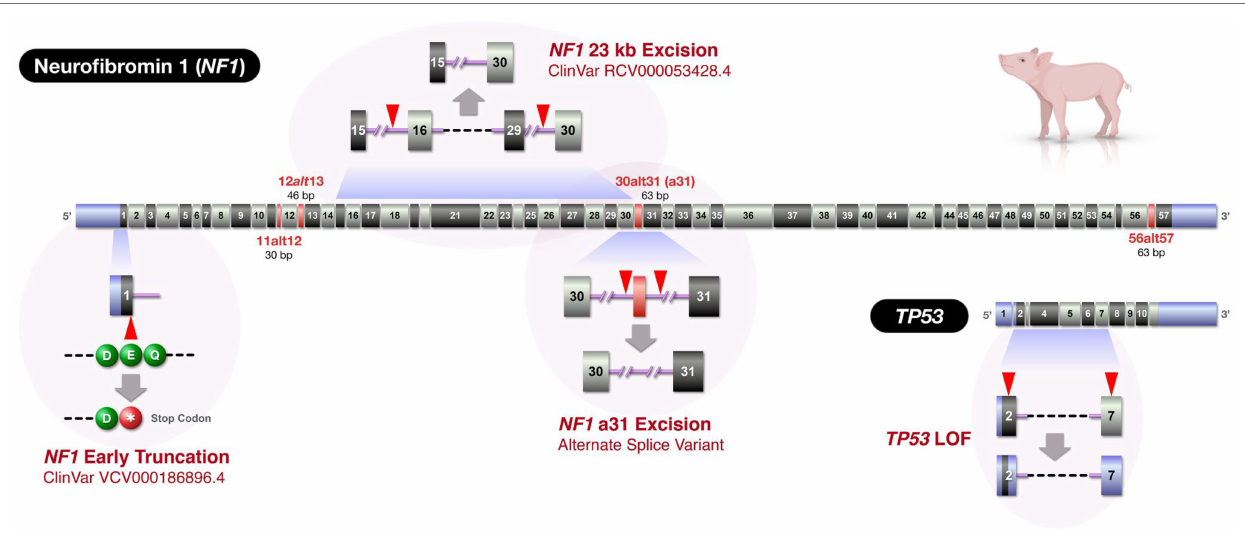
FIGURE 2 | Swine NF1 and TP53 gene maps and locations of genetic alterations in the novel swine models. The figure depicts three NF1 edits and a TP53 edit. Due to the large size of the NF1 gene, the figure only displays exonic regions (to relative scale) of the two genes ( NF1 : ENSSSCT00000019317.4 and TP53 : ENSSSCT00000019534.4). Exons displayed as red indicate alternatively spliced exons homologous to those in humans. The exon numbering was based on Ensembl Sscrofa11.1, but alternatively spliced exons were added to provide congruence with previously published human NF1 nomenclature (Anastasaki et al., 2017). When intron lengths cannot be depicted to scale, double slashes are displayed. Blue exonic regions: untranslated regions. Red arrowheads: Cas9 target